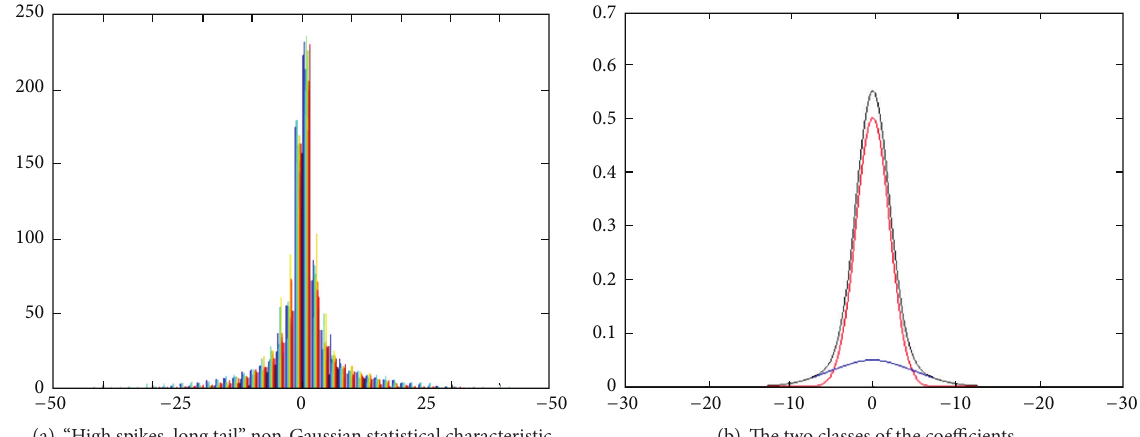
Figure 2: Statistics of the image NSCT coefficients.